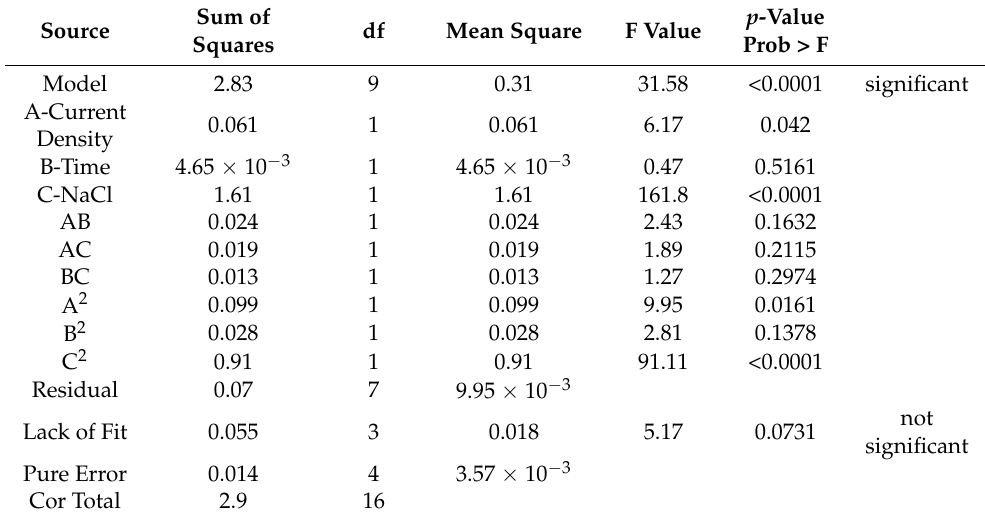
Table 4. ANOVA analysis